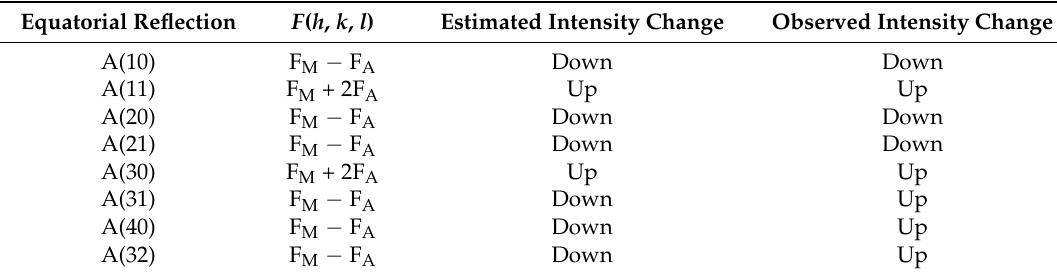
Table 3. Intensity changes expected on the equatorials with a simple model as in Equation (10), compared to what is